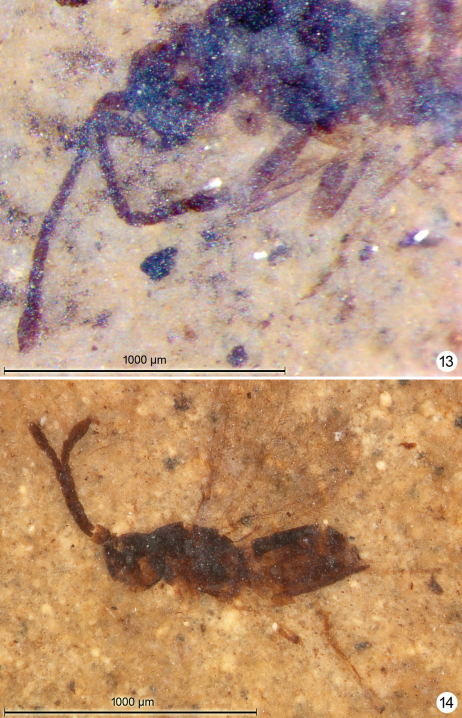
Gonatocerus spp. 13
Gonatocerus rasnitsyni holotype, mesosoma, head, antennae 14
Gonatocerus greenwalti holotype, habitus lateral.